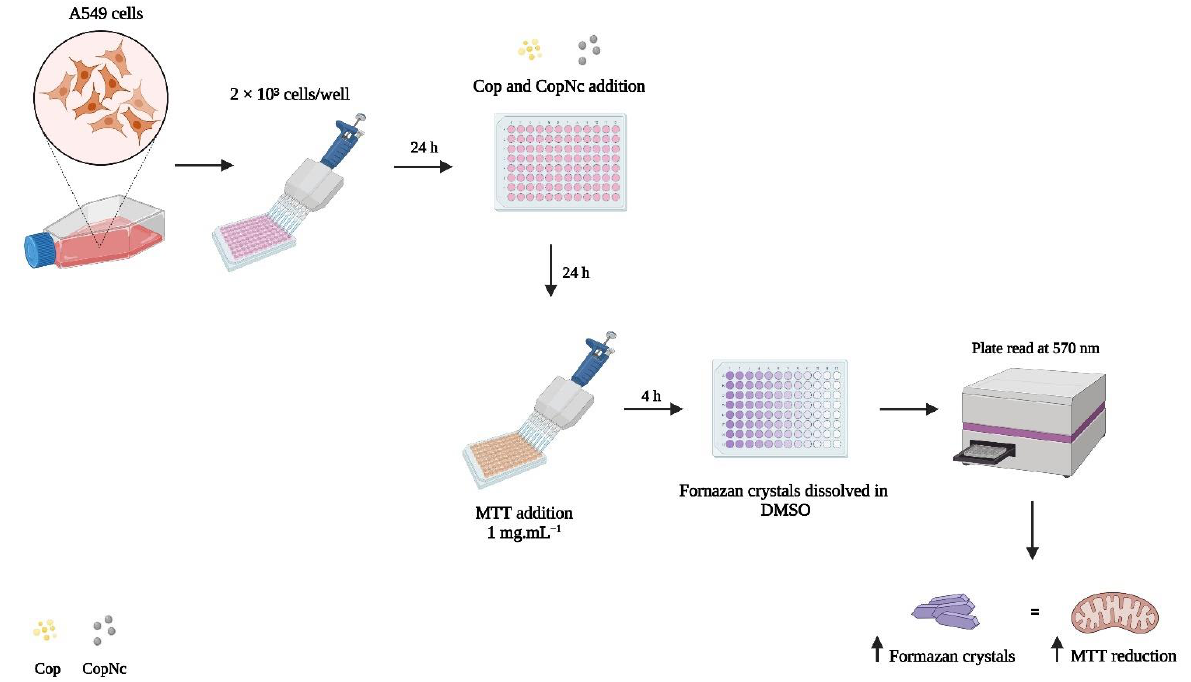
Scheme 2. Representation of the experimental protocol for the cytotoxicity assay based on the MTT reduction by mitochondria enzymes of Cop and CopNc on A549